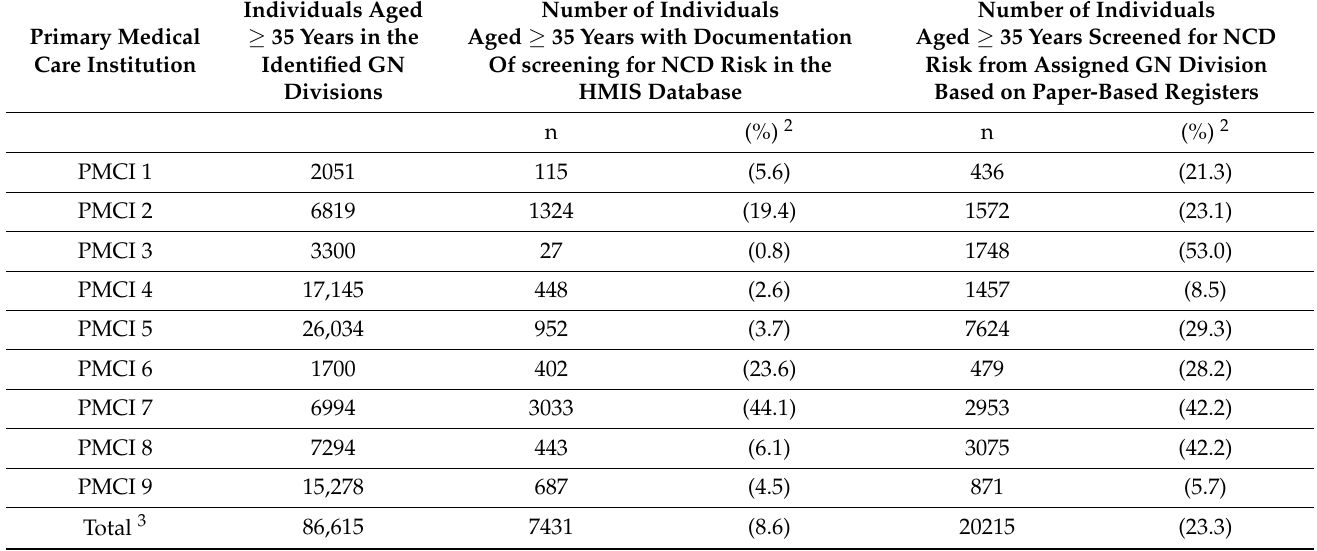
Table 1. Estimated percentage of individuals aged ≥ 35 years assigned to the PMCI who underwent screening for NCD risk factors 1 in the nine selected PMCIs supported by the PSSP in Sri Lanka, 2021.